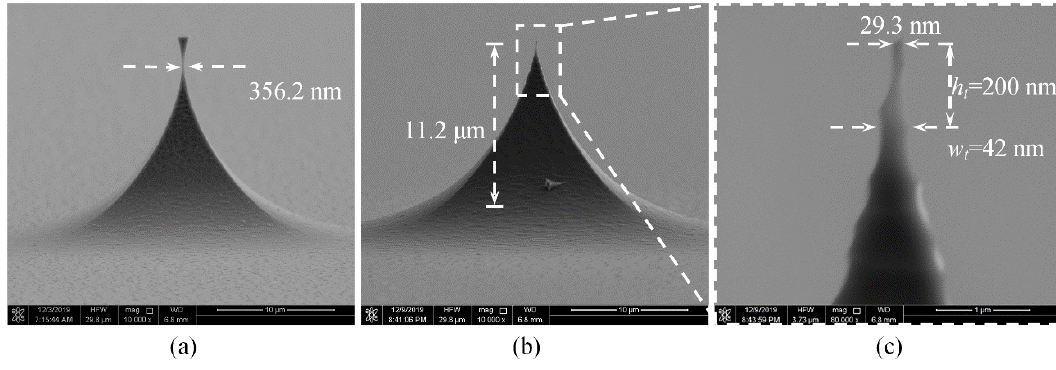
Figure 10. SEM images of pre-tip ( a ) and tip after oxidation sharpening ( b , c ).